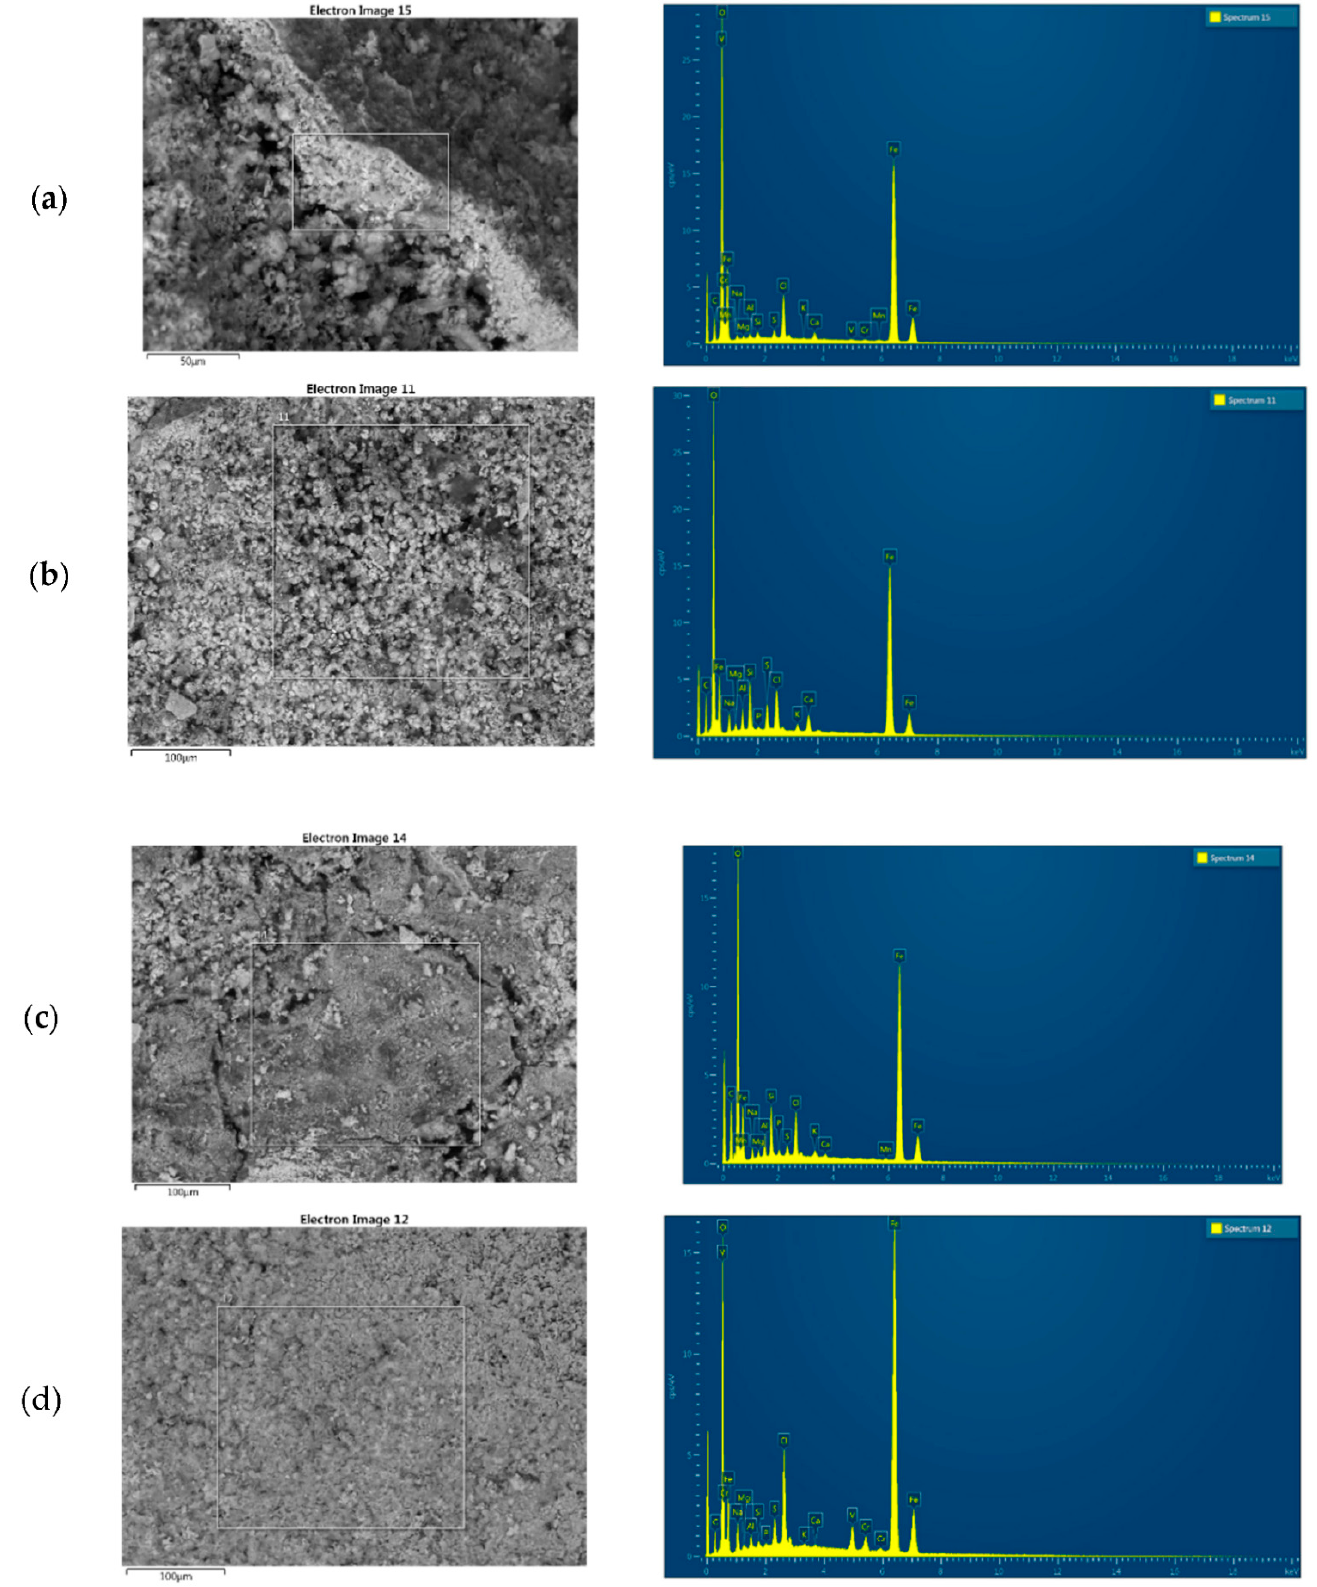
Figure 11. ( a–d ). EDS spectra of iron rusts adapted from [10]. Figures 11 and 12 indicate that chlorine has a major influence but becomes more pro- nounced between 1.6 and 2.6%. This seems to disprove the idea that more chlorine means there is more pitting corrosion, which holds true in a controlled environment but not a